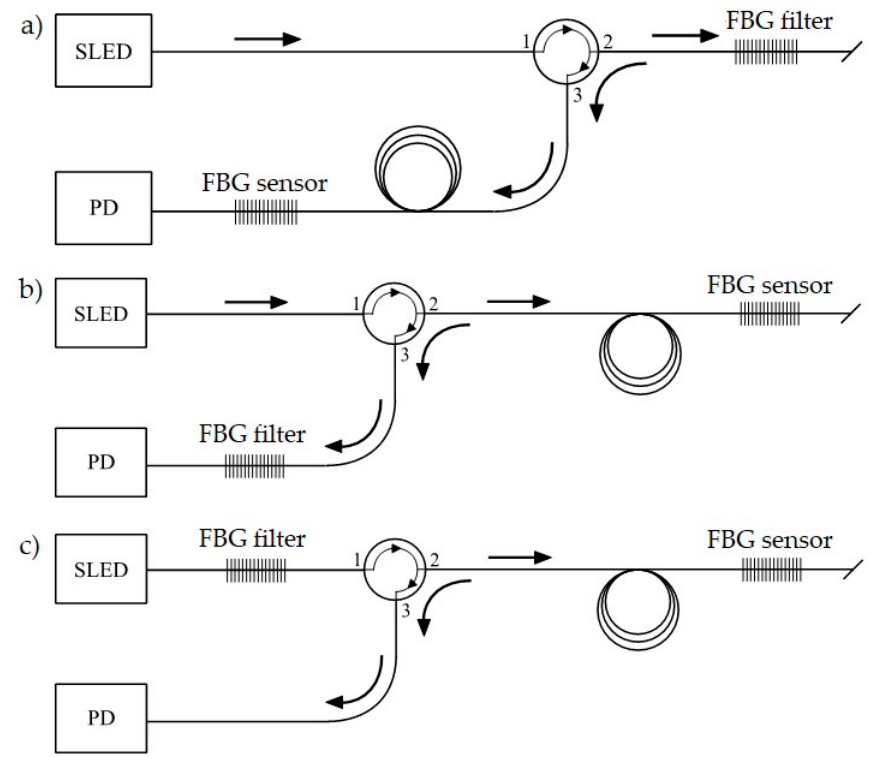
Figure 3. The interrogation system for the overhead transmission line wire sag measurement: ( a ) Sensor located in the photodetector arm; ( b ) sensor located in the sensing arm; ( c ) sensor located in the input arm. SLED: superluminescent light-emitting diode; PD: photodetector.